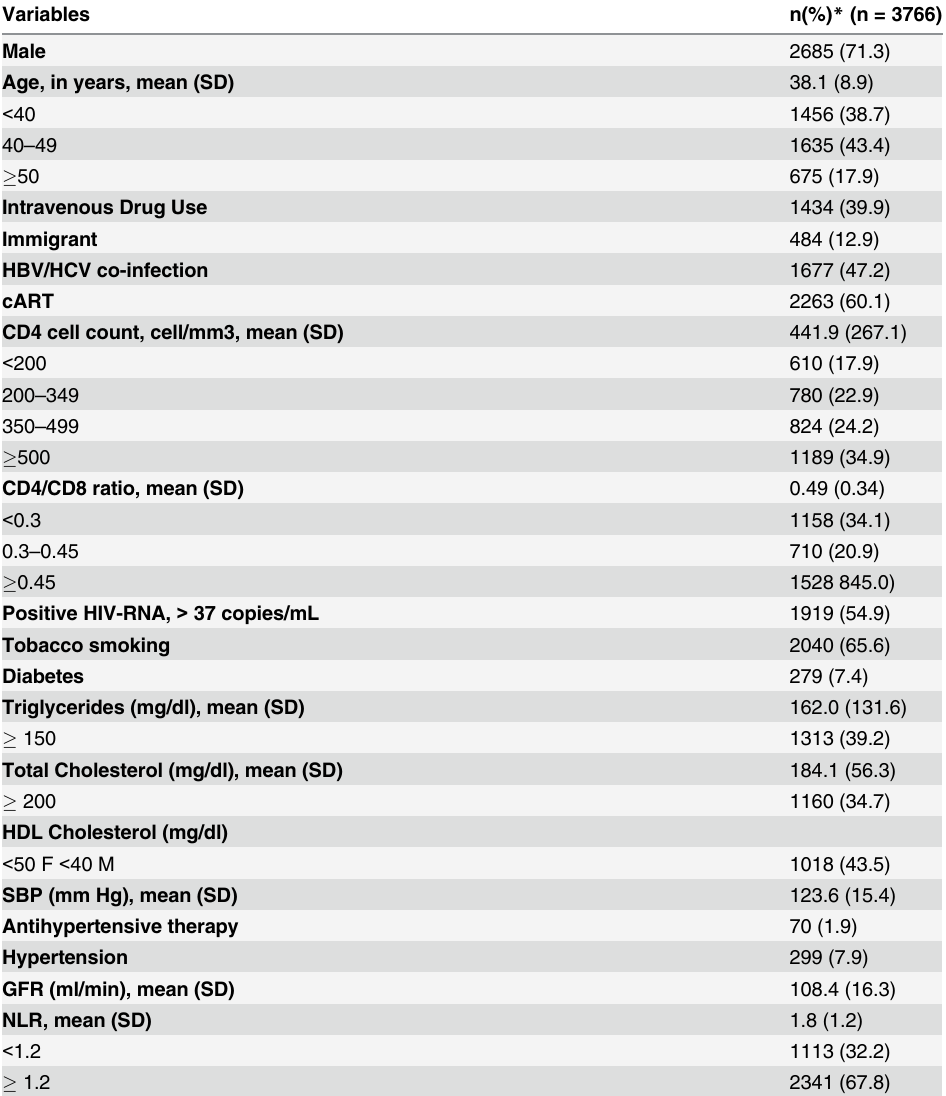
Table 1. Demographical and clinical features at enrolment.